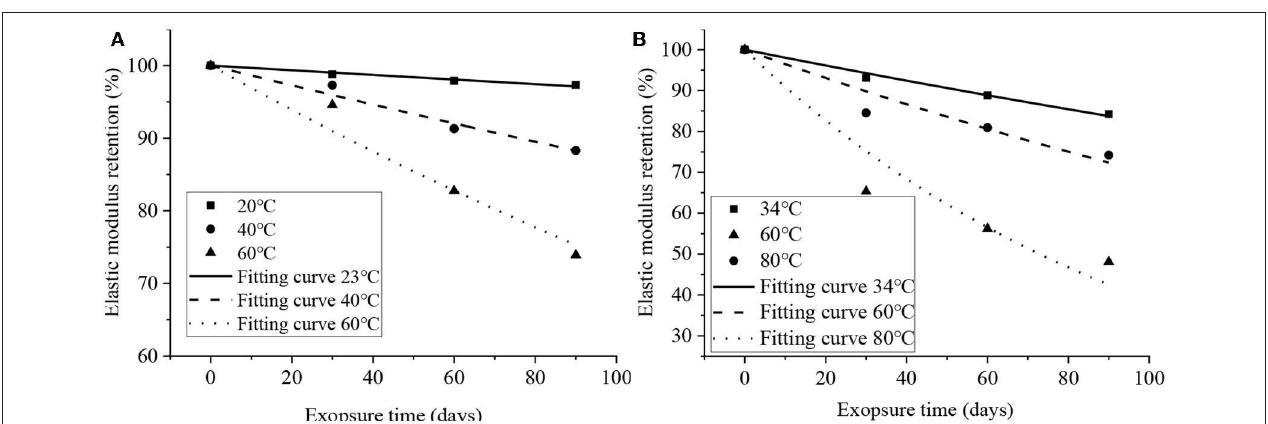
FIGURE 4 | Fitted curves for tensile strength retention vs. time: (A) Liu et al. (2016) and (B) Zhang (2008).